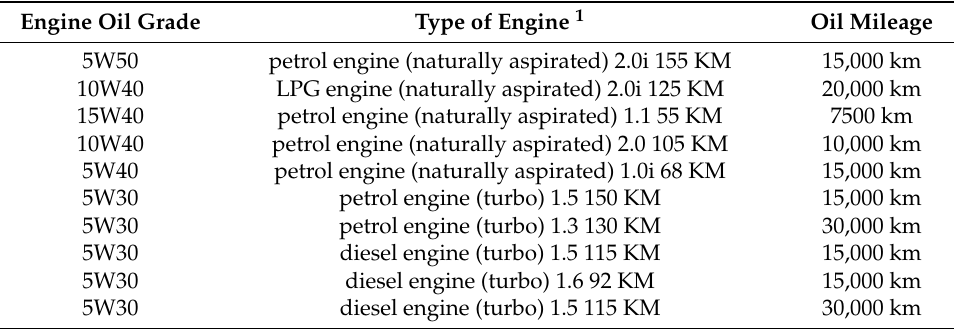
Table 1. Summary of engine oils (and their mileage) applied in the experiments. Engine Oil